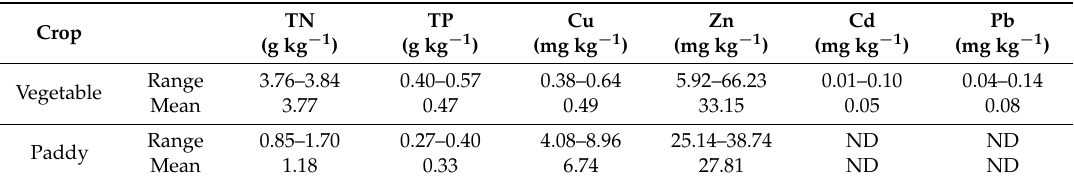
Table 9. Contents of heavy metals in vegetables and rice grown in soils in the vicinity of sample pig